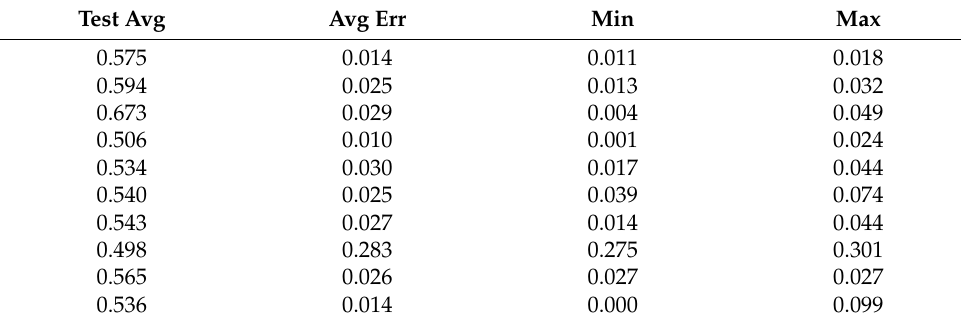
Table A145. Set 2, trials 41–50 data (single 0.5 PR value).